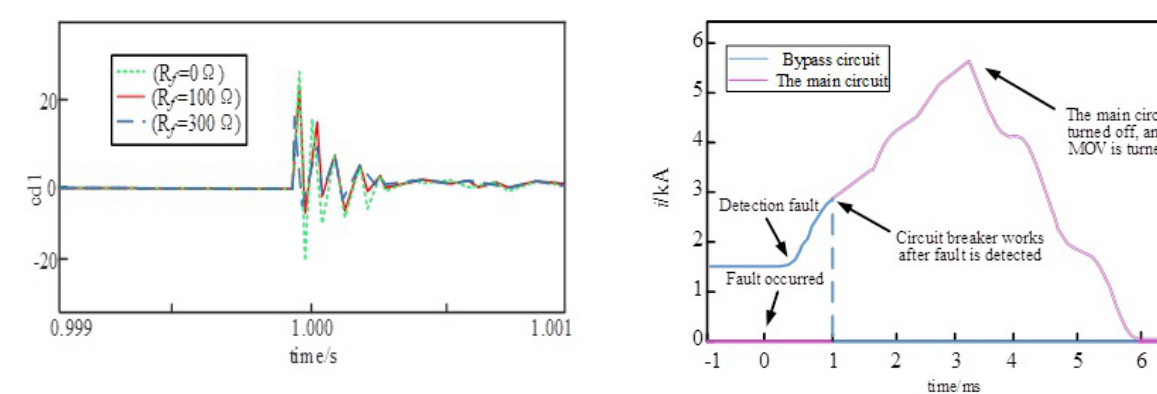
Fig. 13. Dynamic response of hybrid DC